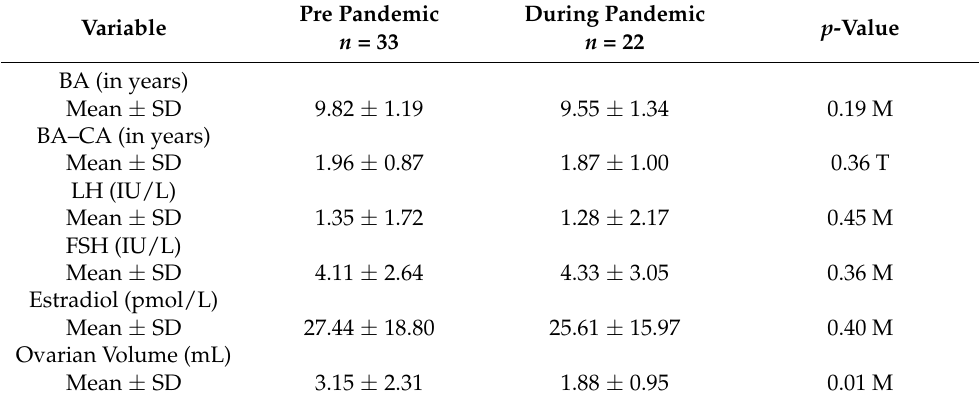
Table 2. Laboratory and radiological characteristics of girls with precocious puberty before and during the COVID-19 pandemic ( n =